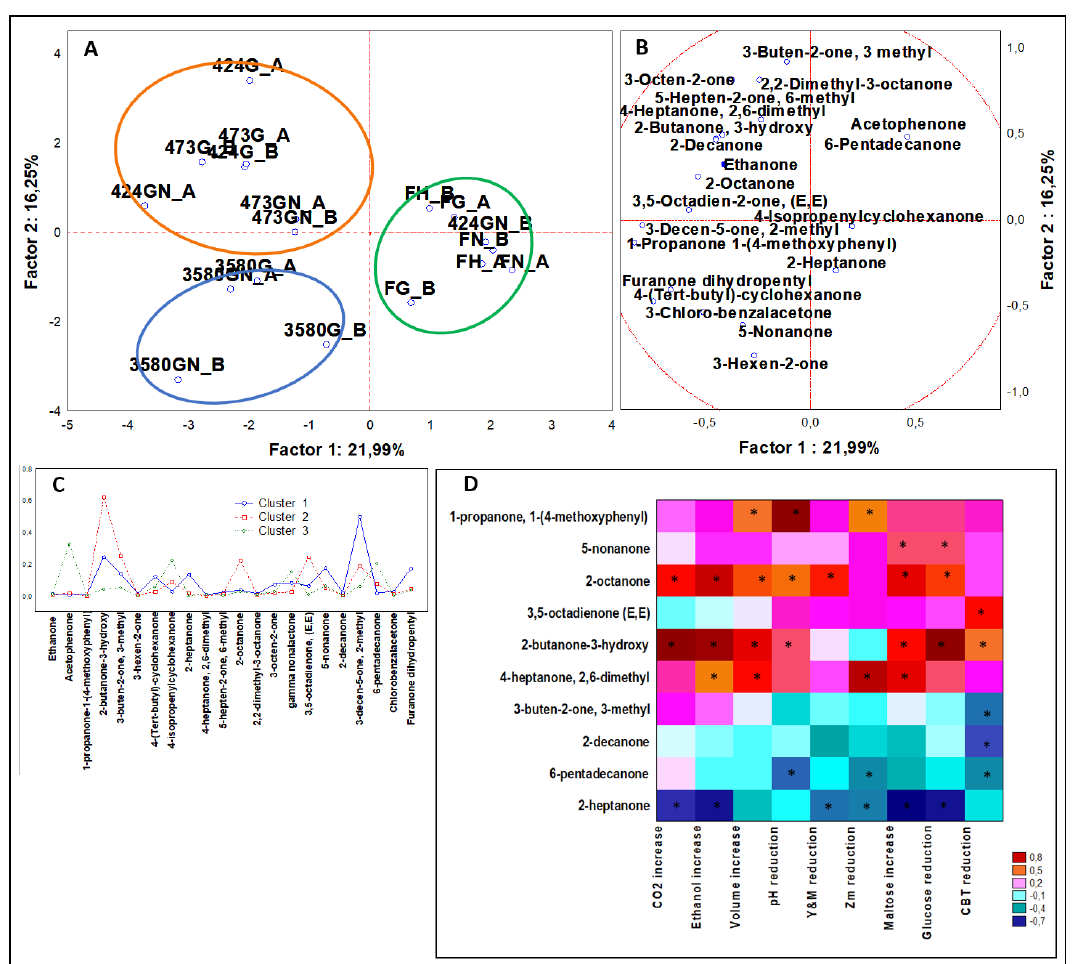
Figure 5. ( A ) PCA of cases and ( B ) variables on ketones; ( C ) K-means clustering; ( D ) Spearman